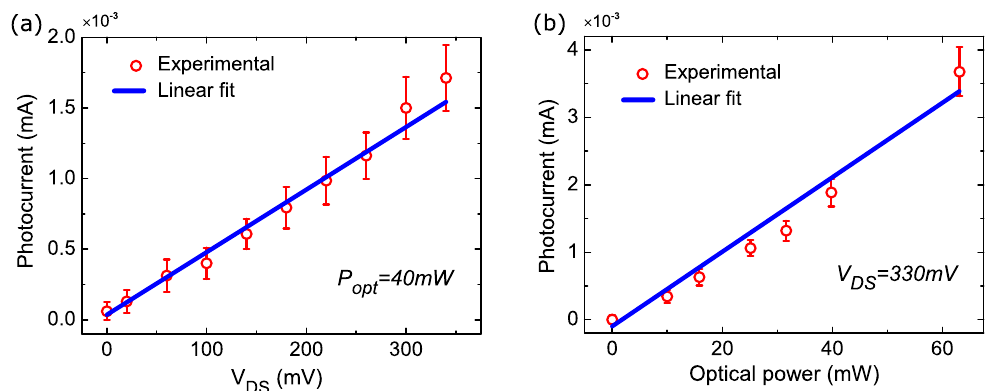
Fig. 3 Photocurrent measurements. a Photocurrent as a function of V DS at 40 mW optical power, b photocurrent as a function of the optical power, at V = 330 mV. Error bars are obtained from the VNA measurement noise standard deviation. DS